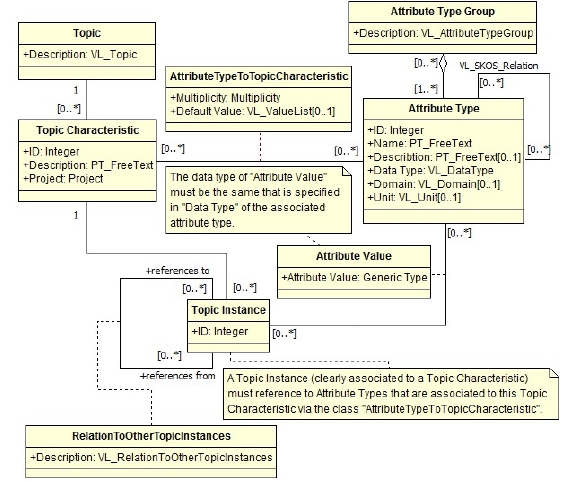
Figure 2. UML application schema of the project